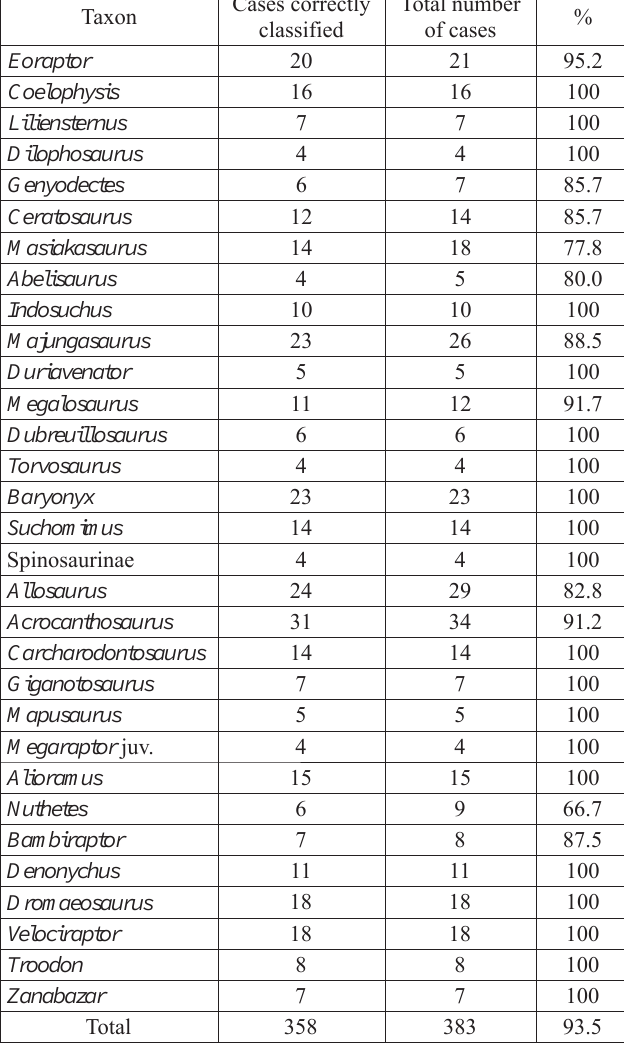
Table 1. Original grouped cases correctly classified compared to the total number of each taxa based on classification matrix for the discrim- inant analysis using 31 taxa including the standard dataset provided by Smith et al. (2005), Smith and Lamanna (2006), and Hendrickx et al. (2015).